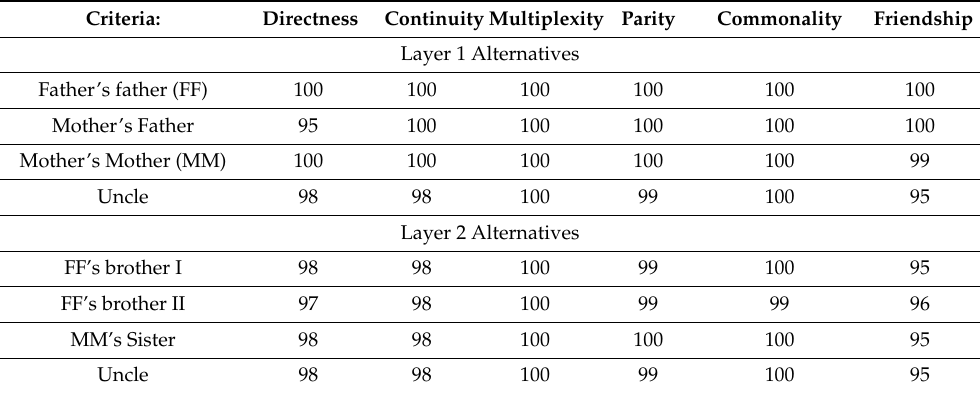
Table 1. Nomination values.